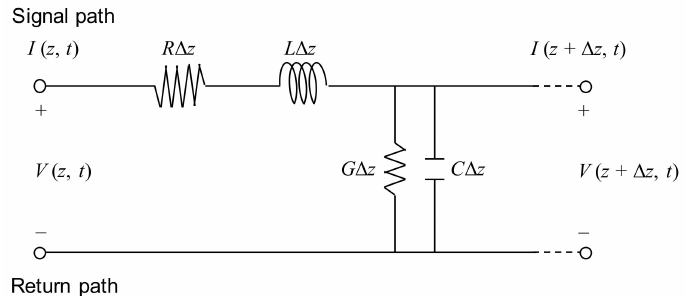
Figure 1. Circuit model of di ff erential length ∆ z of a two-conductor transmission